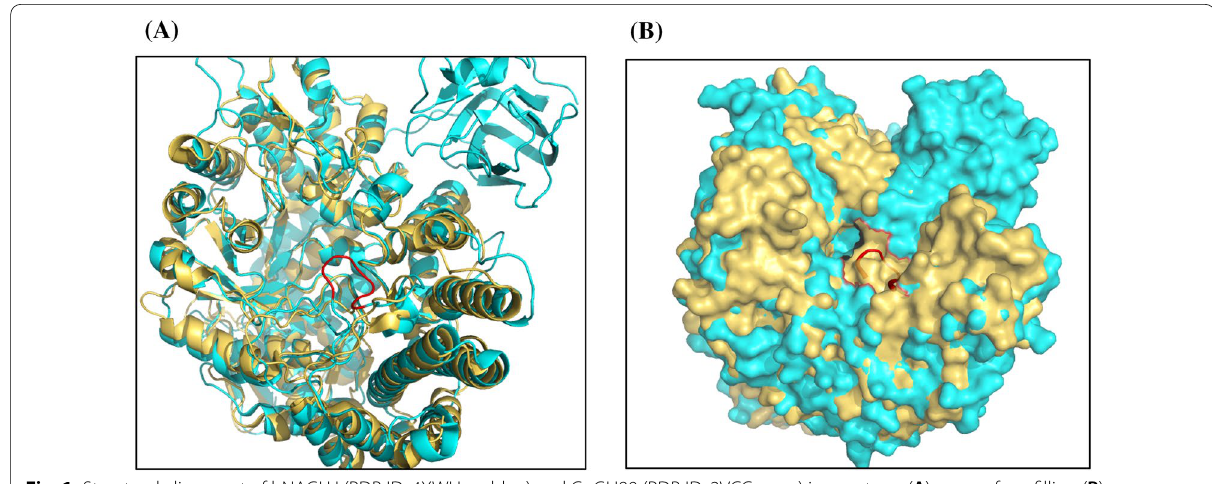
Fig. 1 Structural alignment of hNAGLU (PDB ID: 4XWH, golden) and CpGH89 (PDB ID: 2VCC, cyan) in a cartoon ( A ) or a surface‑filling ( B ) representation. An extra loop in CpGH89 (residues 680–686) containing W685, the key residue for the recognition of GlcNAcα1–4Gal motif in CpGH89 (Birrane et al. 2019; Ficko‑Blean and Boraston 2012), was shown in red in a cartoon presentation. The figures were generated with